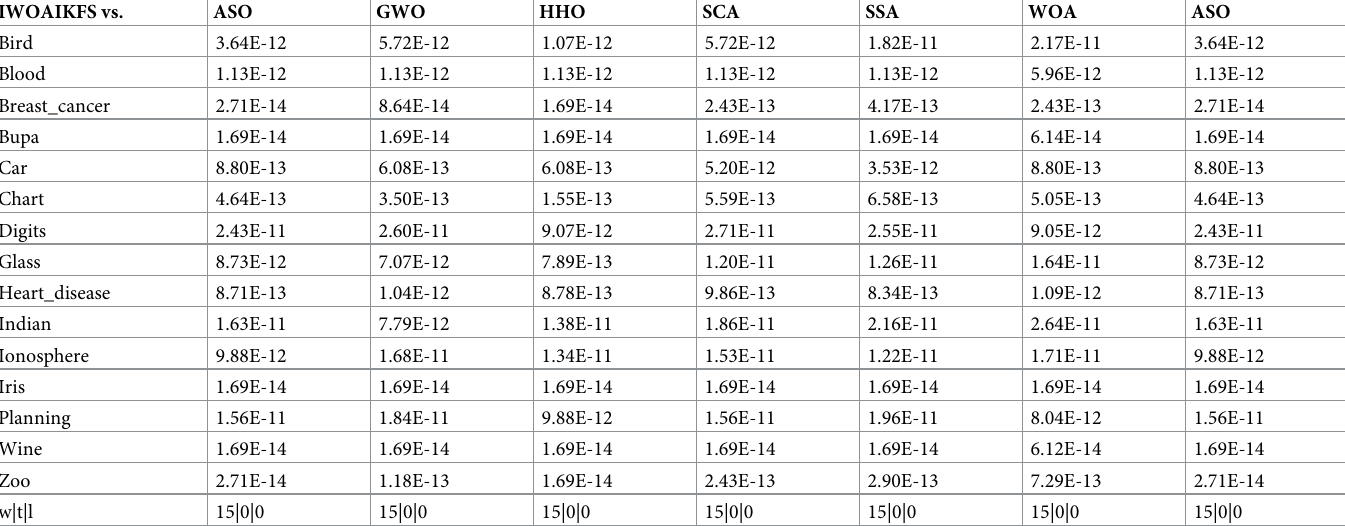
Table 11. p- value of the Wilcoxon test for the classification accuracy results of IWOAIKFS and other optimizers ( k = 5 and p > = 0.5 are in bold). IWOAIKFS vs.